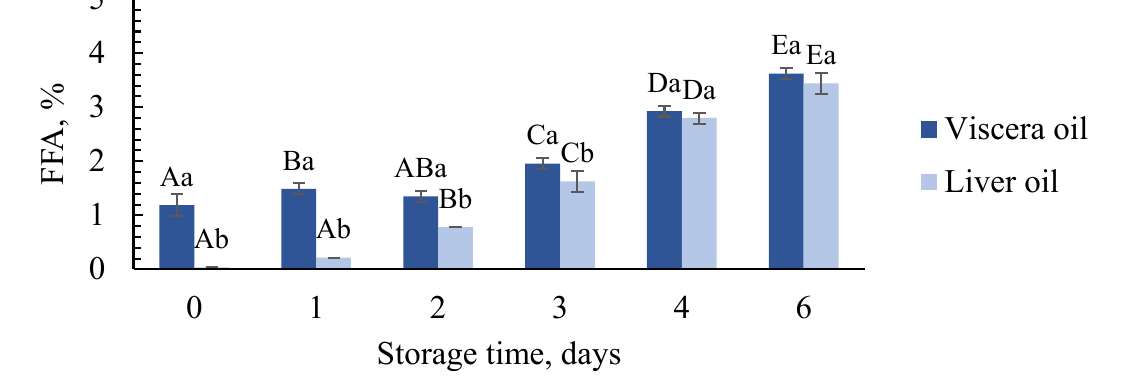
Figure 3. FFA content (as % oleic acid) in oil produced from viscera and liver at different storage days. Significant difference ( p < 0.05) is shown as different letters between days for the same raw material ( A–E ) and between raw materials for the same day ( a–b ).